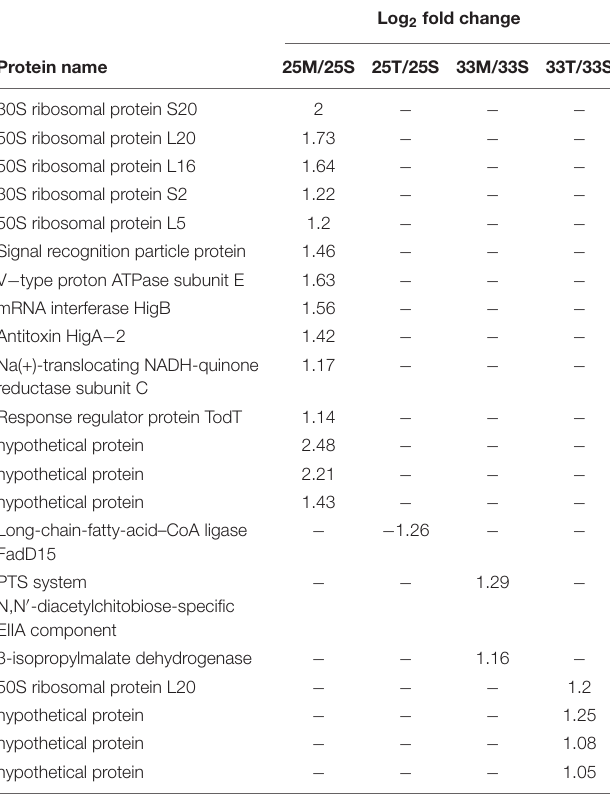
TABLE 1 | List of significantly changed proteins ( p -value < 0.05) which have log 2 fold change > 1 from the coral lysate